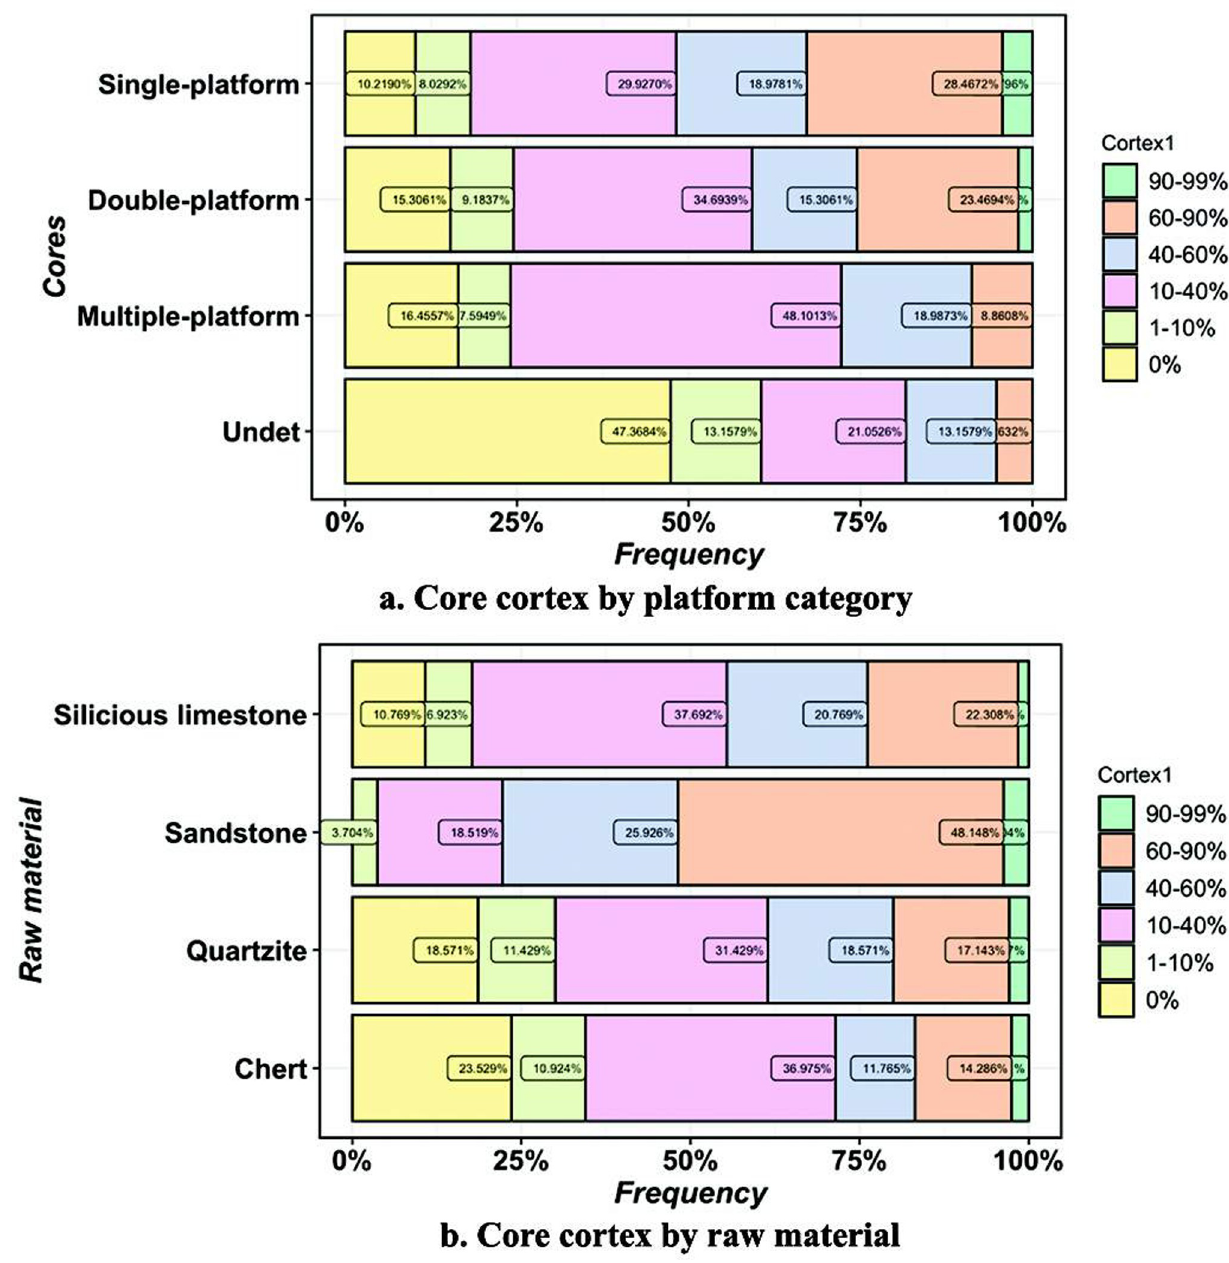
Fig 7. The core cortex by core platforms and raw